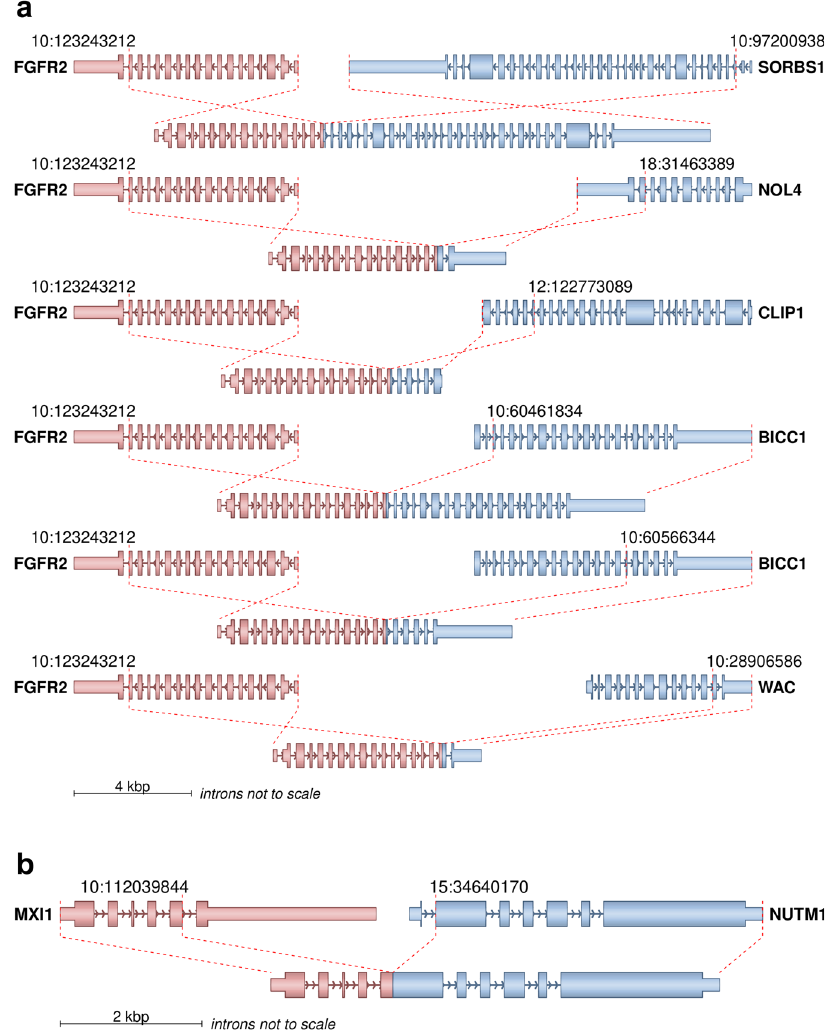
Fig. 3 Fusions of high con fi dence. Exon structures in transcriptome sequencing data are shown. a Fusions involving FGFR2 found in six patients. Fusion partners were CLIP1 , NOL4 , WAC , SORBS1 and twice BICC1 . b Fusion involving NUTM1 found in one patient. MXI1 has not been described previously as a fusion partner for NUTM1 , but NUTM1 fusions do de fi ne NUT midline carcinomas. Therefore, we identify MXI1 as a new possible fusion partner in NUT midline carcinoma. Source data are provided as a Source Data fi